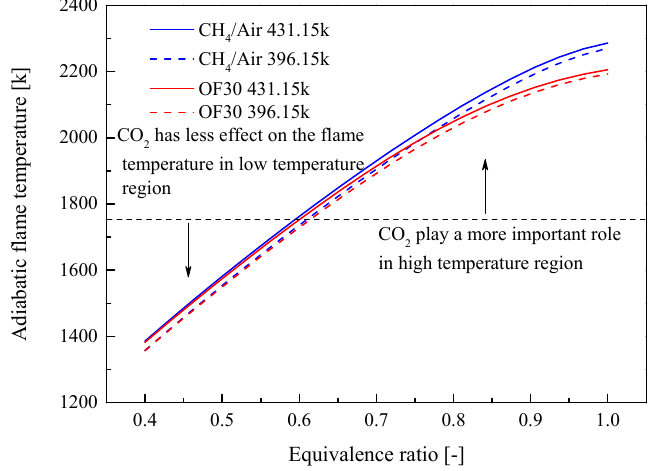
Figure 5. Adiabatic flame temperature of the CH 4 /air and OF30 flames.